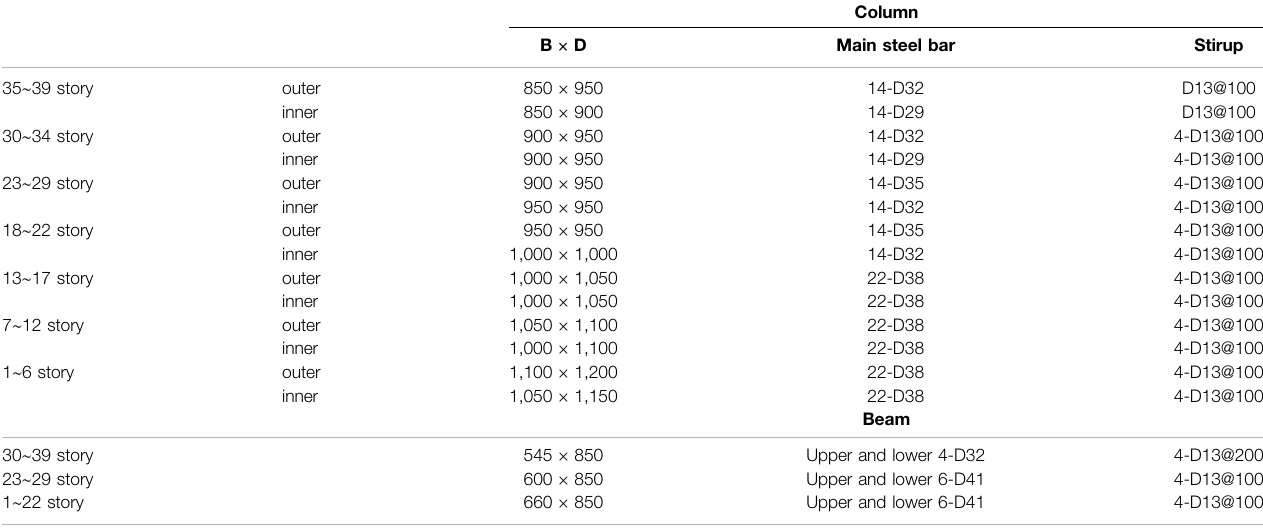
TABLE 1 | Member parameters of plane frame.